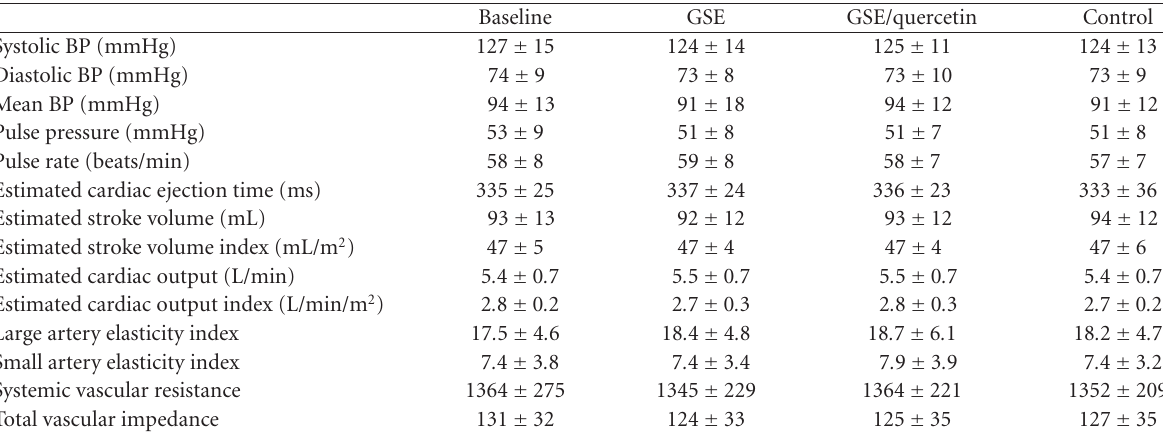
Table 1. Cardiovascular measures produced by the HDI compliance instrument; mean of 35 complete measures ± SD.